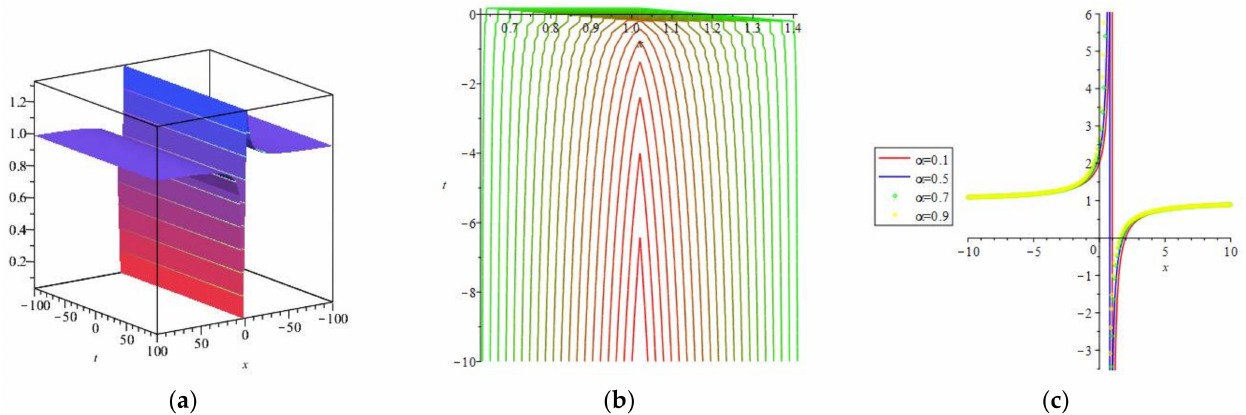
Figure 5. The graphical representation of the solution λ 23 ( χ ) : ( a ) 3D shape, ( b ) contour plot, and ( c ) 2D graph.